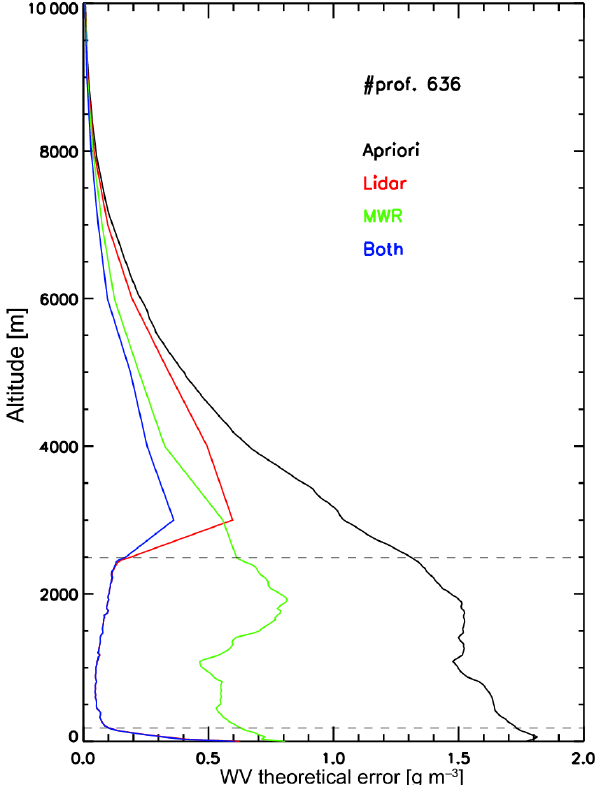
Figure 8. Mean theoretical error over 636 clear sky cases during the complete HOPE period. The lidar data have been artificially cut off at 2.5km. In black: a priori uncertainty. Red: only-RL. Green: only MWR. In blue: the MWR+RL. The dashed horizontal lines enclose the region where the lidar data are used.